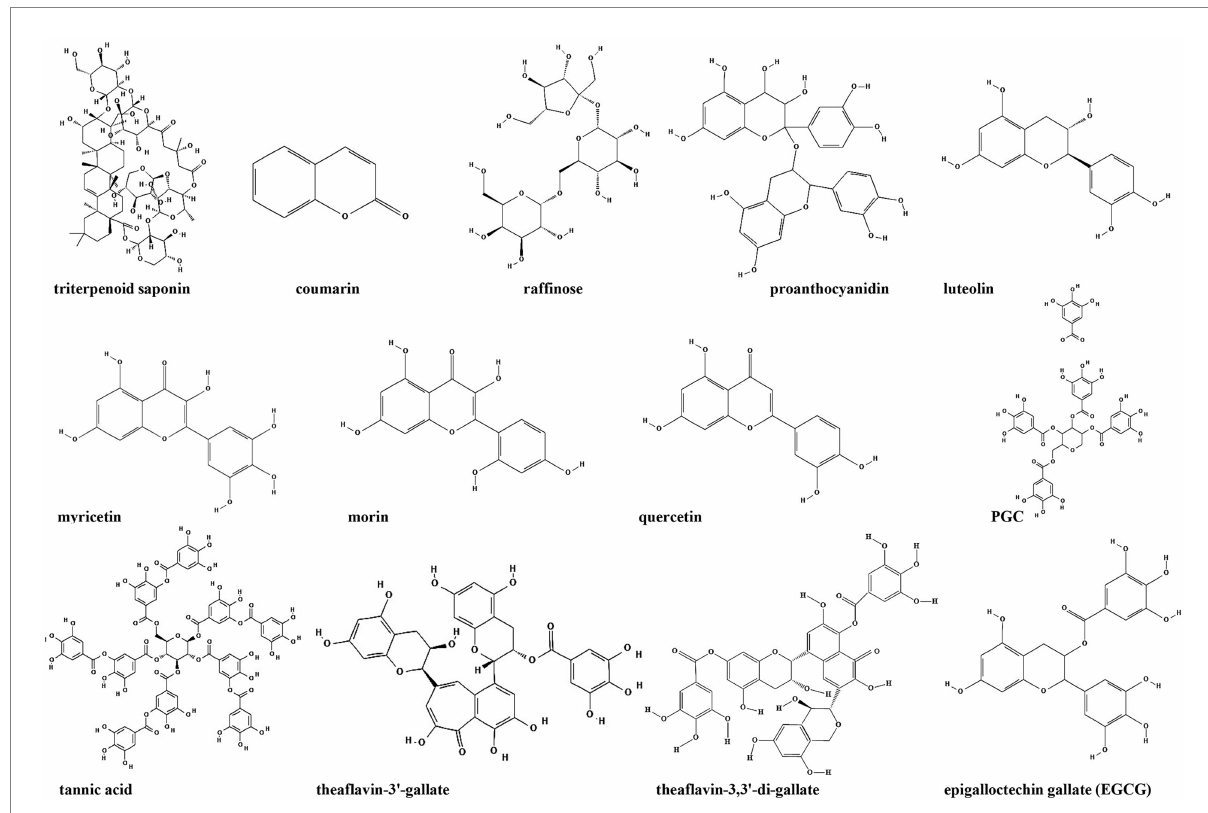
FIGURE 8 Chemical structures of the compounds that inhibit biofilm formation via second messengers ( − related) signaling pathways. ChemDraw software has been utilized to draw the chemical structures of the